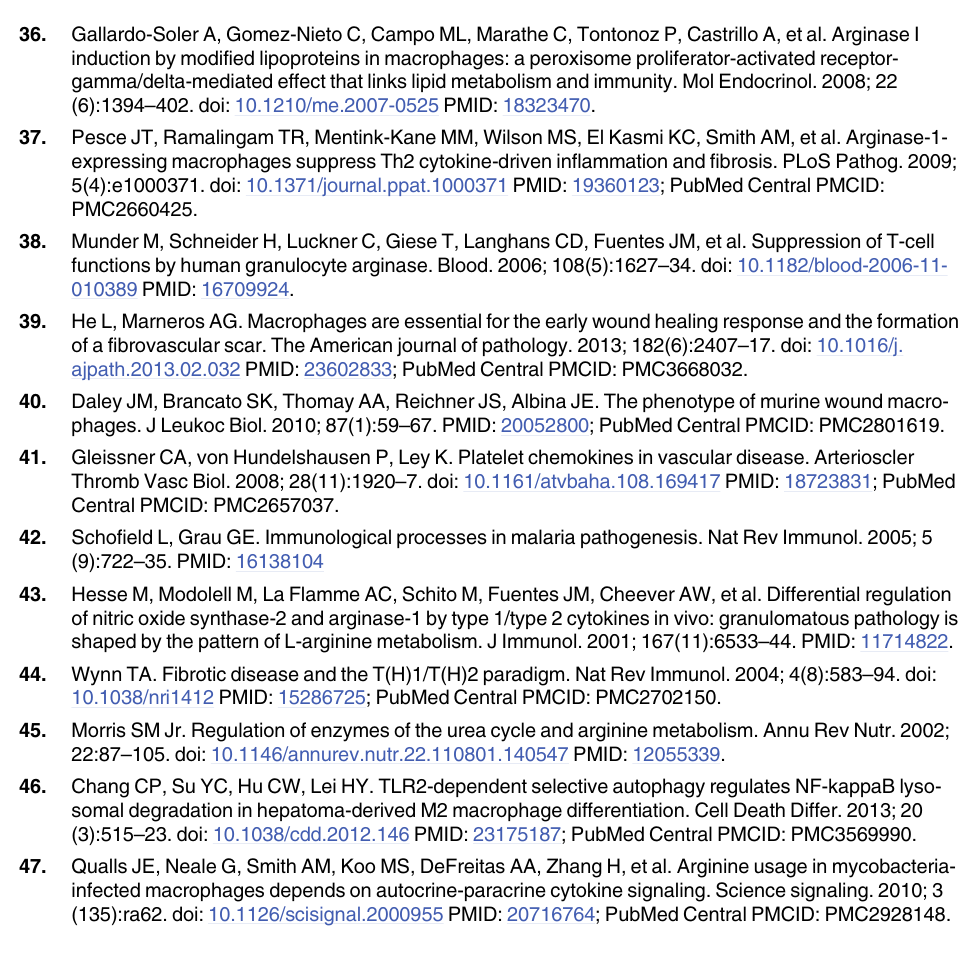
PLOS ONE | DOI:10.1371/journal.pone.0162208 September 2,